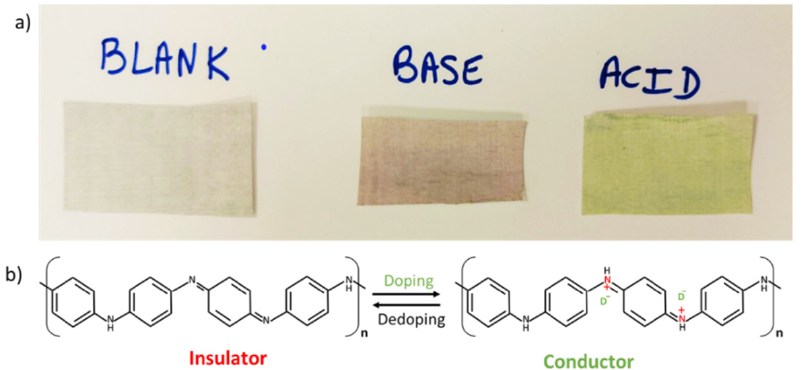
Figure 2. ( a ) Illustration of color changes in the PANI/MW/P1 films at (right) pH = 1 and (middle) pH = 13. ( b ) Schematic structure of PANI depicting the doping/de-doping process.